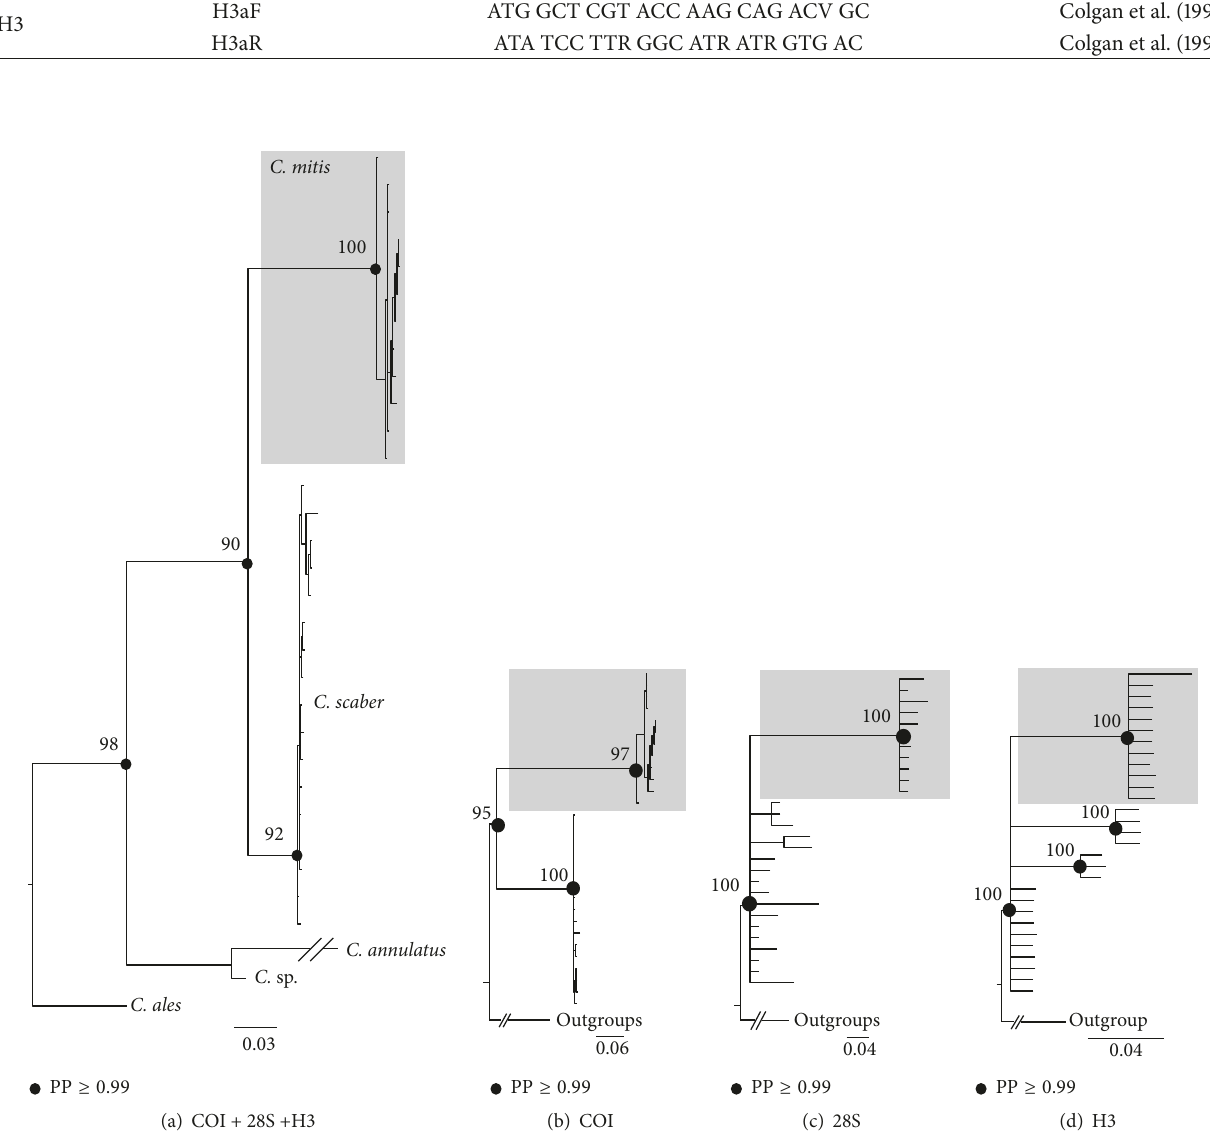
Figure 1: Bayesian topologies of Ctenoides scaber and C. mitis. (a) Concatenated gene tree. (b)–(d) Individual gene tree for COI, 28S, and H3, respectively. Shaded individuals belong to the C. mitis clade and nonshaded ones belong to the C. scaber clade. Posterior probabilities (PP) that are greater than 99% were denoted with black dots on the nodes. Bootstrap values that are greater than 90% (based on maximum likelihood analysis) were labeled above the